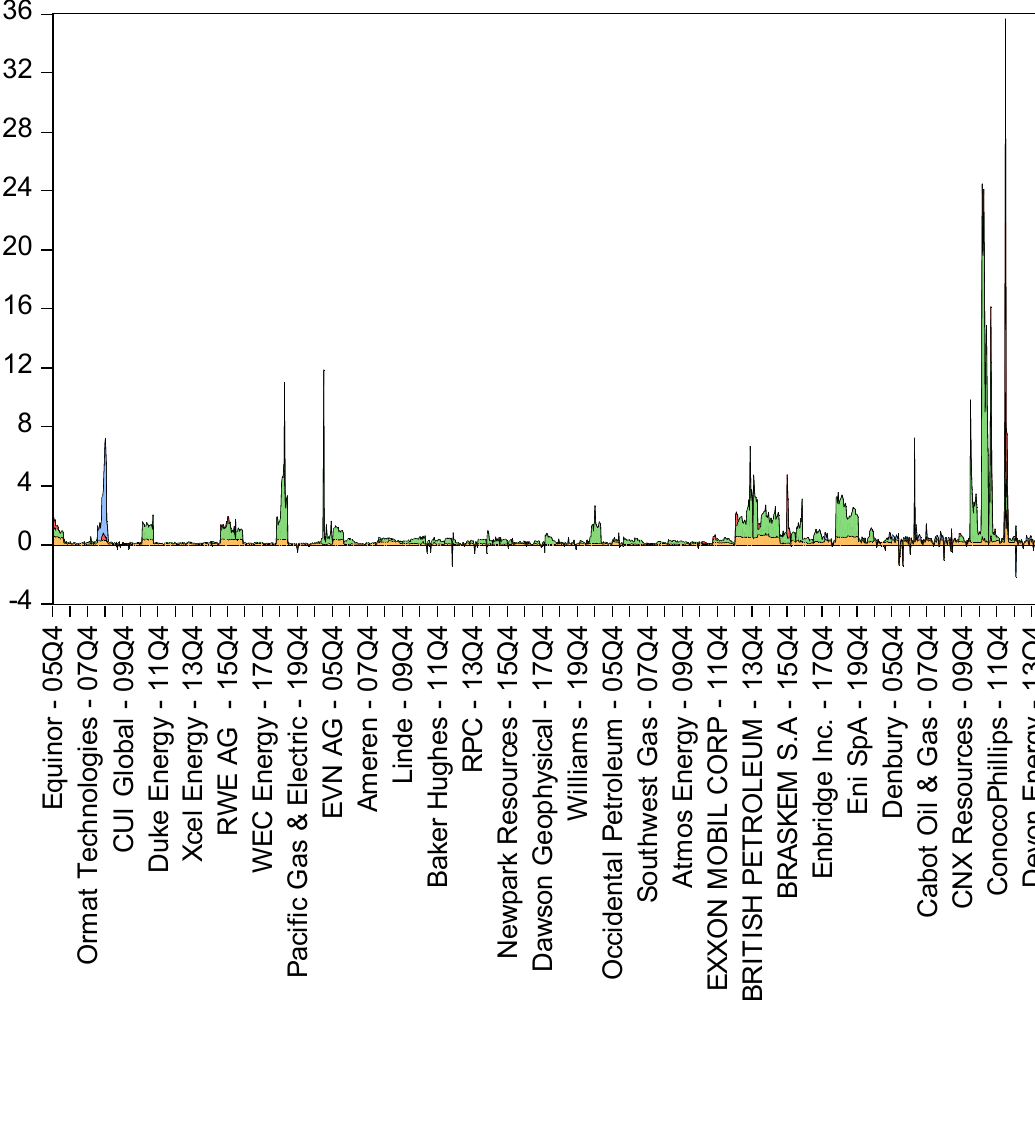
Table 1. Descriptive statistics for electricity companies.